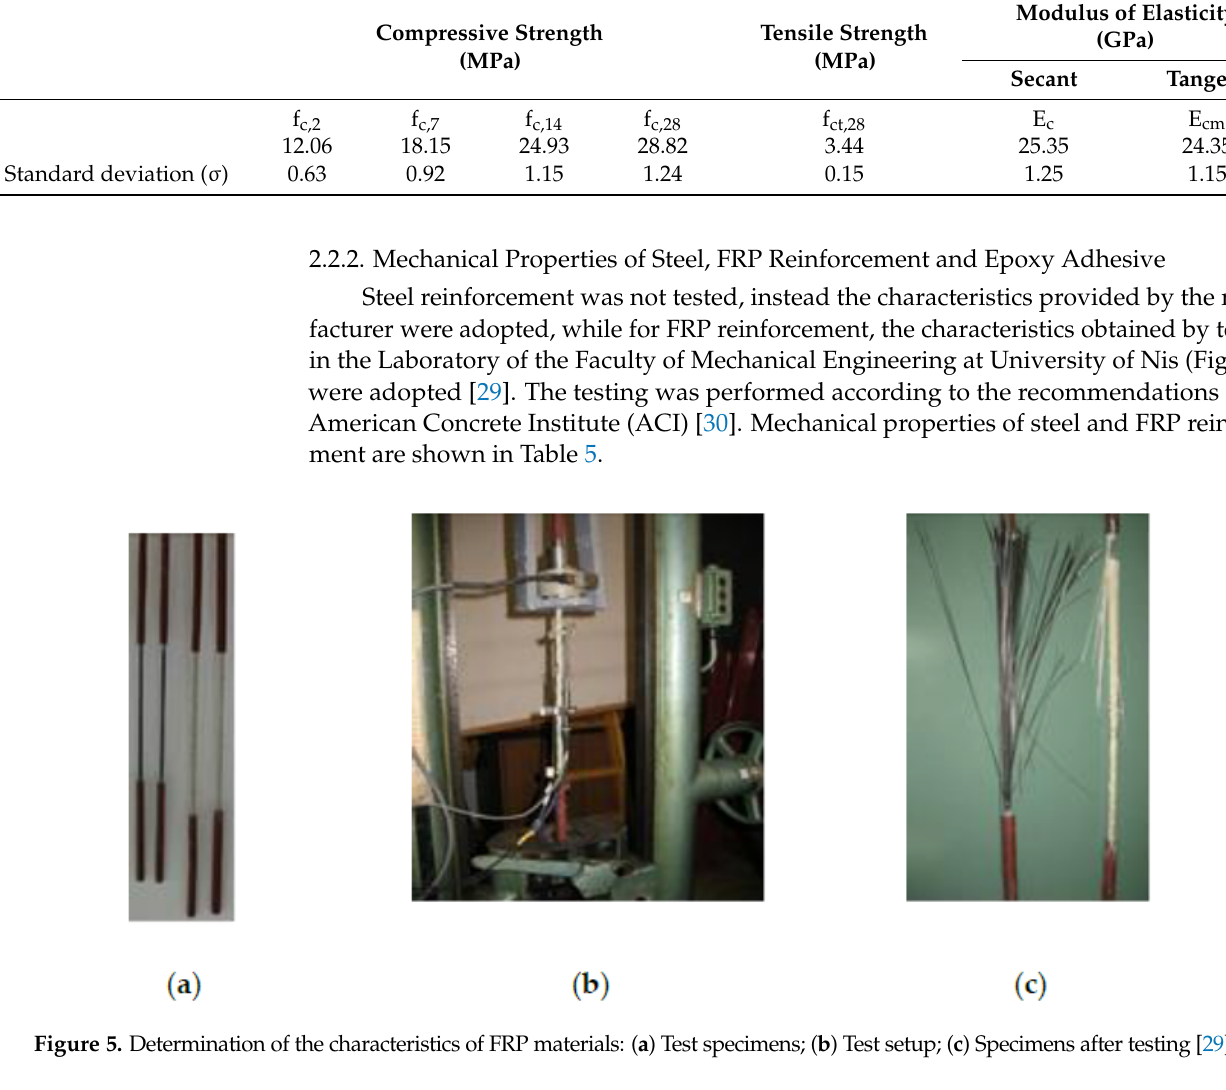
Table 4. The test results obtained on hardened concrete.